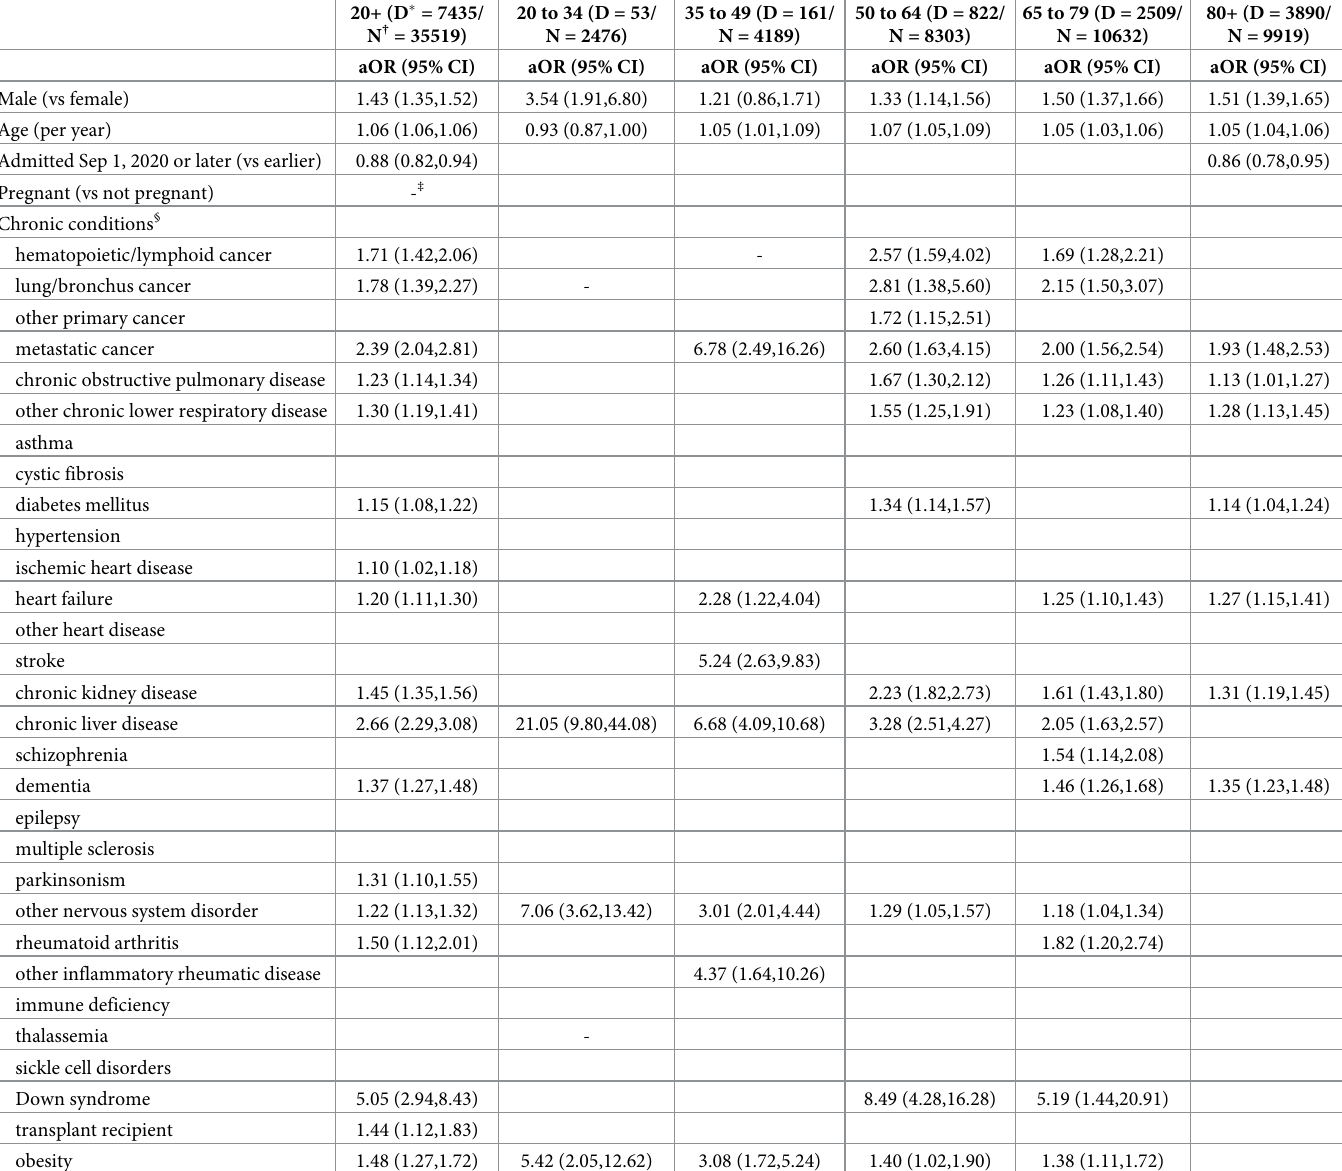
Table 3. Associations between demographic, temporal and health characteristics and death in hospital among adults aged 20+ years during first acute care hospital- izations with a confirmed or suspected COVID-19 diagnosis in Canada by life-course age